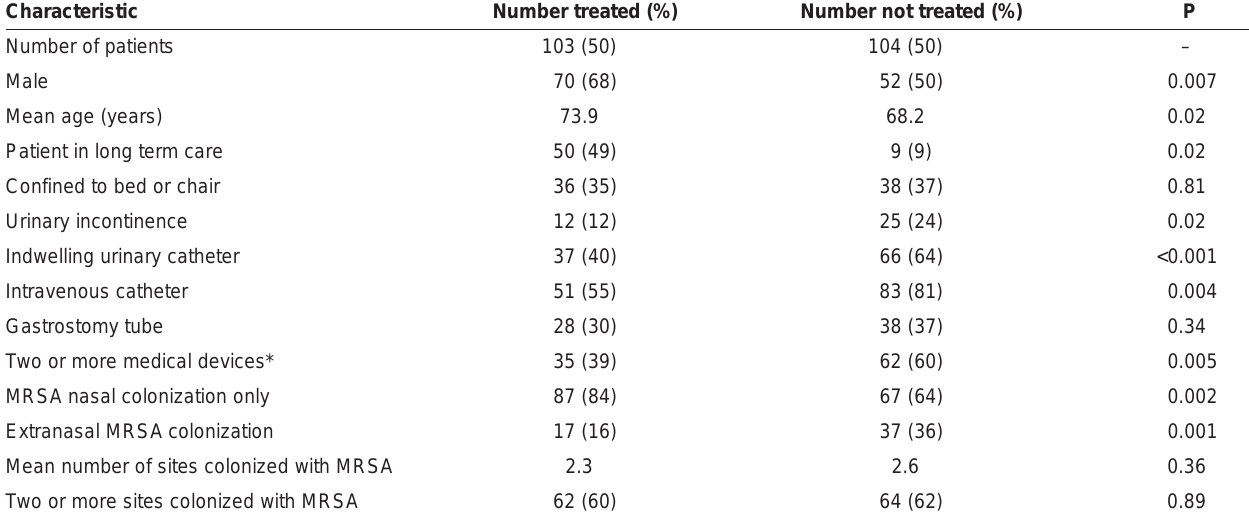
TABLE 1 Baseline characteristics of patients who were and were not treated for methicillin-resistant Staphylococcus